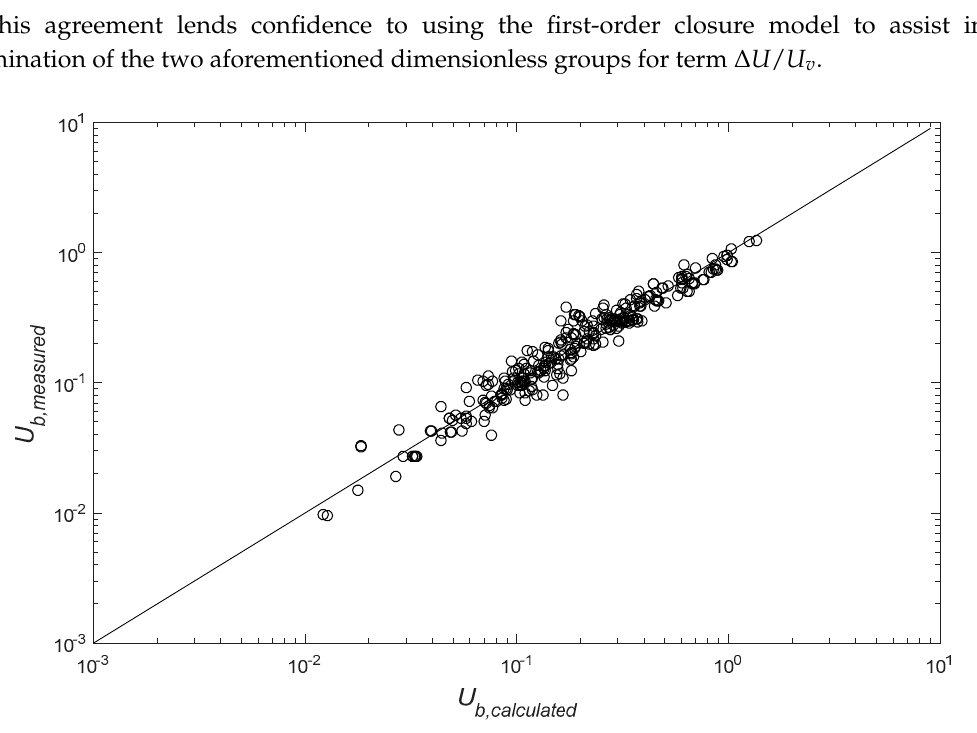
Figure 2. Comparison between measured and modeled bulk velocities (m/s) using the first-order closure model along with C d,array and the mixing length model featured in Figure 1.